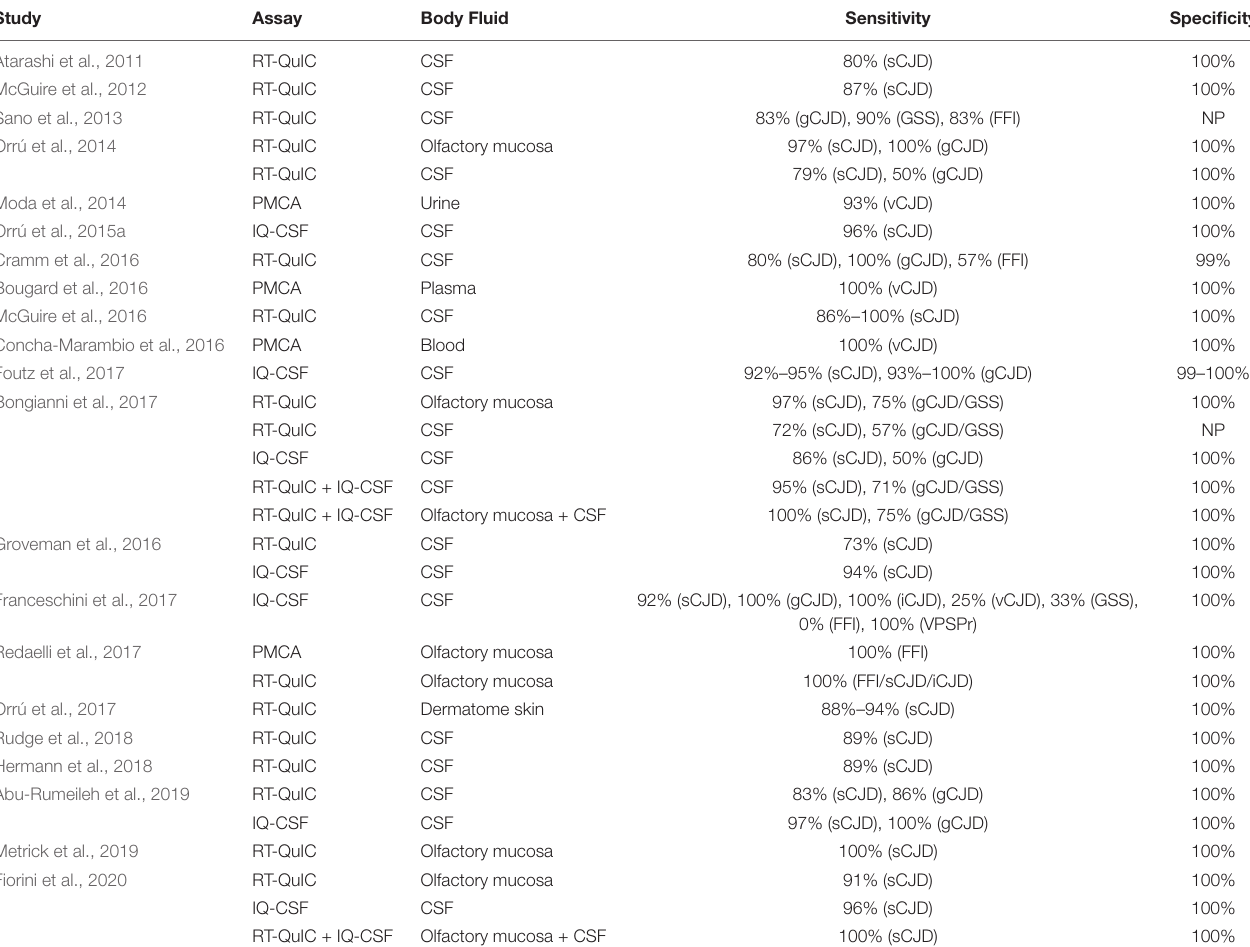
TABLE 3 | Performance of PMCA and RT-QuIC for PrP Sc detectionin non-brain samples from human patients with TSEs.